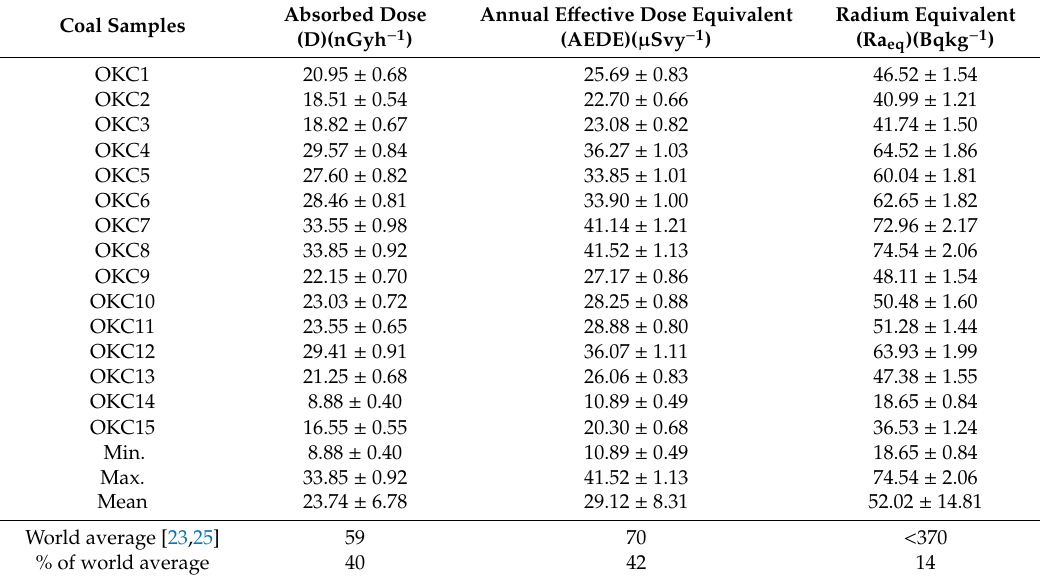
Table 6. Radiological hazard indices for radionuclides in Omelewu coal samples. Coal